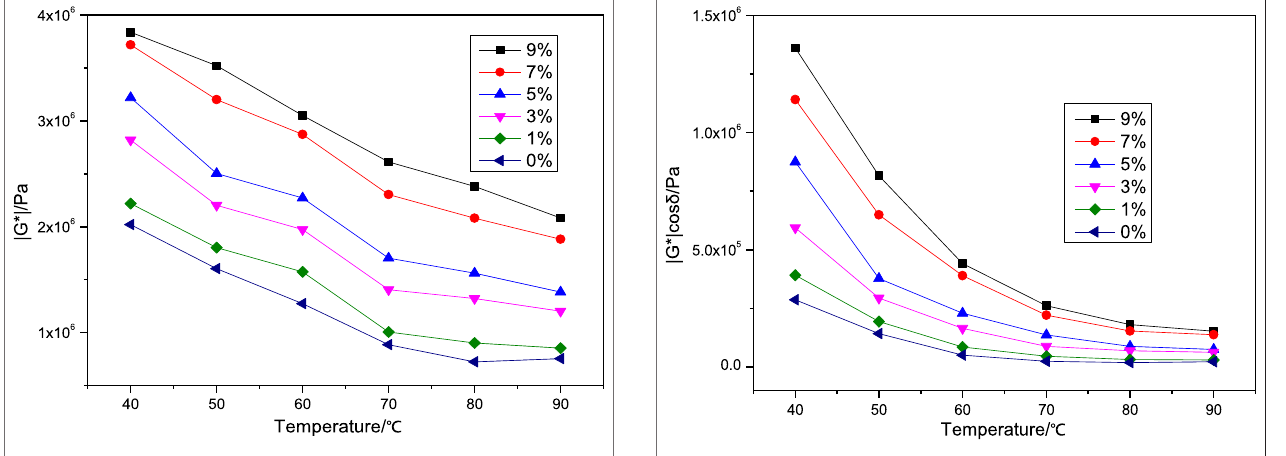
FIGURE 11 | Effect of PP-g-MAH content on |G*|cos δ of modi fi ed asphalt.